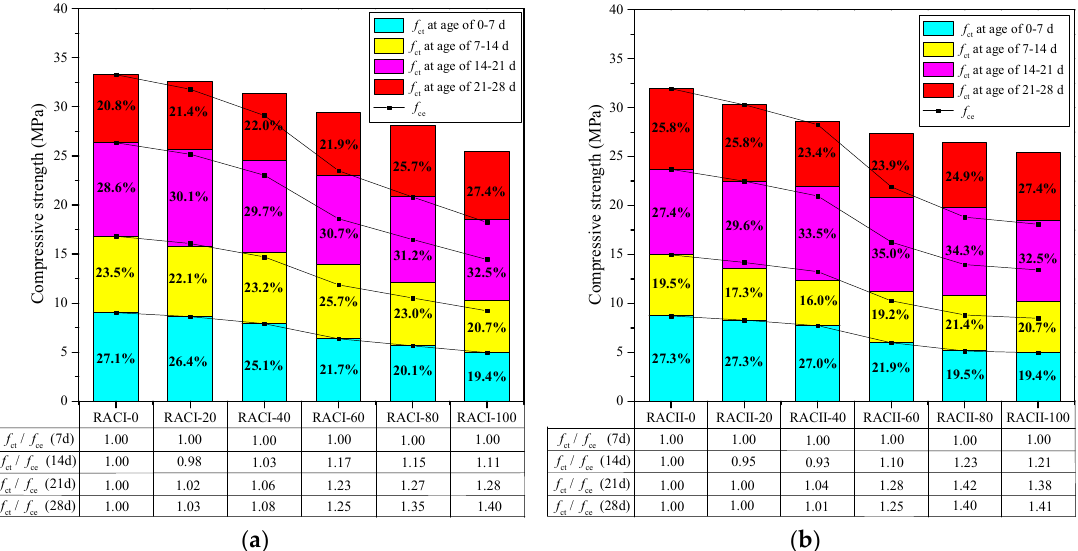
Figure 5. Compressive strength of RAC with RBA: ( a ) RACI; ( b ) RACII.